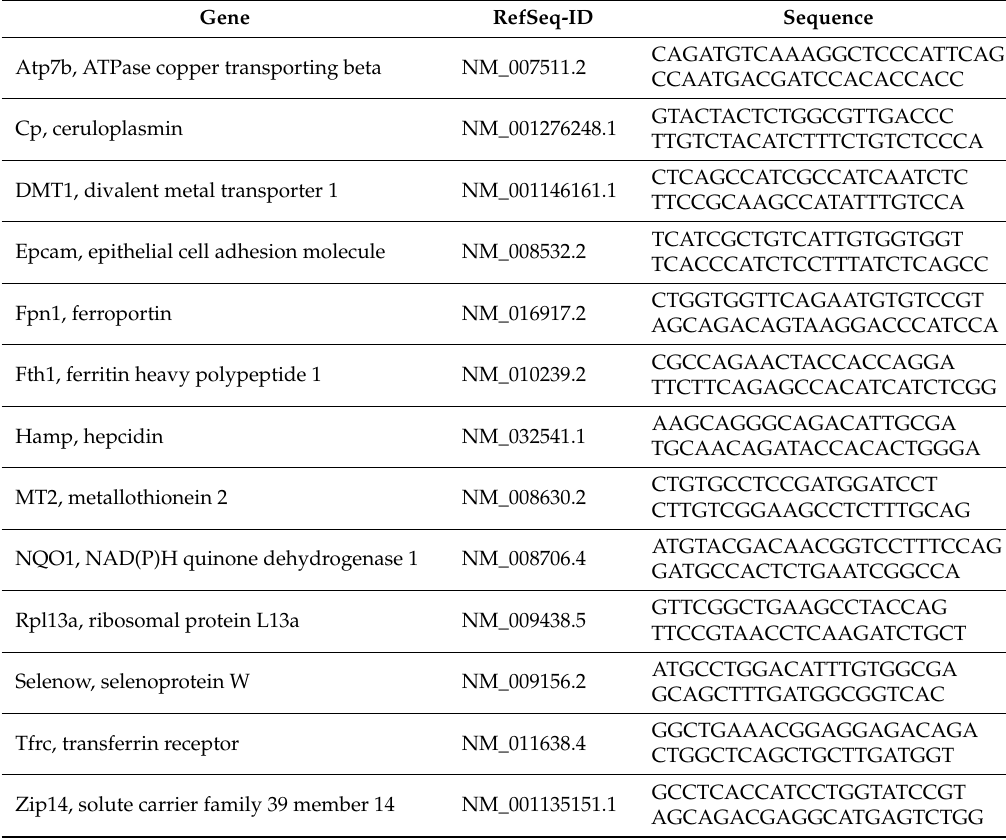
Table 3. Primer sequences (5 (cid:48) → 3 (cid:48)